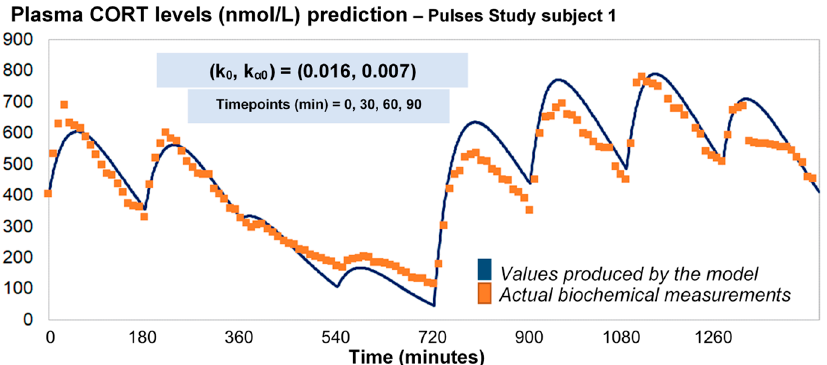
Figure 4. Assuming discretely varying absorption and clearance rates (revised model), the brute-force search method provides the initial pair of (k 0 , k α 0 ), based on four CORT measurements (e.g., at time points 0, 30, 60 and 90 min), and subsequently estimates the whole 24-h profile of plasma cortisol. The data from the Pulses study Subject 1 was used (see Materials and Methods). CORT: cortisol, k: clearance rate, k α : absorption rate. Time points of delivery (magnitude of doses): 0 min (2.3 mg/230 μ L), 180 min (2.3 mg/230 μ L), 360 min (0.5 mg/50 μ L), 540 min (0.5 mg/50 μ L), 720 min (4 mg/400 μ L), 900 min (4 mg/400 μ L), 1080 min (4 mg/400 μ L), 1260 min (2.3 mg/230 μ L).